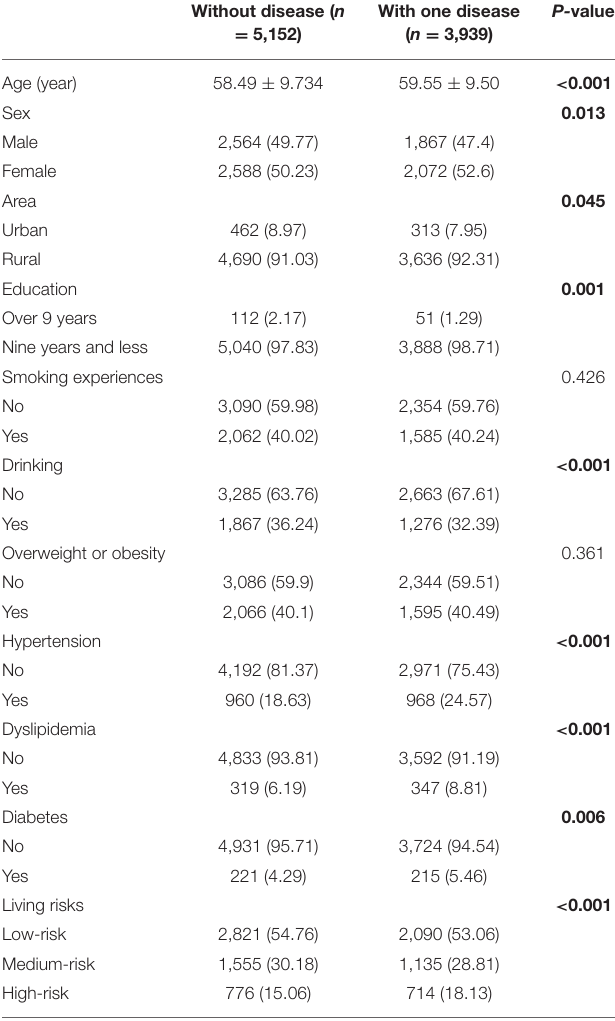
TABLE 1 | Baseline characteristics of participants with or without disease. Without disease ( n With one disease = 5,152) ( n =